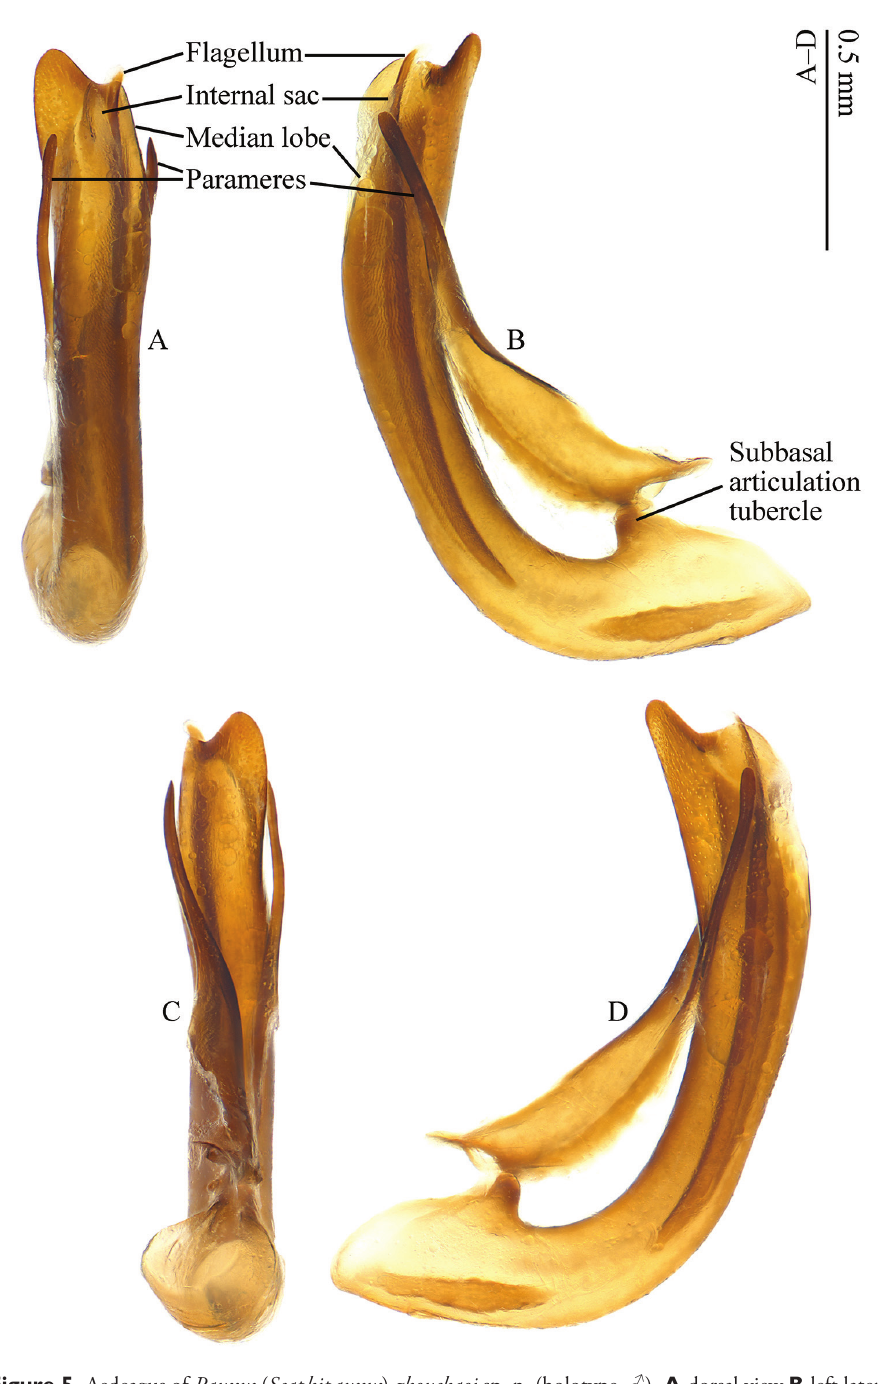
Figure 5. Aedeagus of Paussus ( Scaphipaussus ) zhouchaoi sp. n. (holotype, ♂ ). A dorsal view B left lateral view C ventral view D right lateral